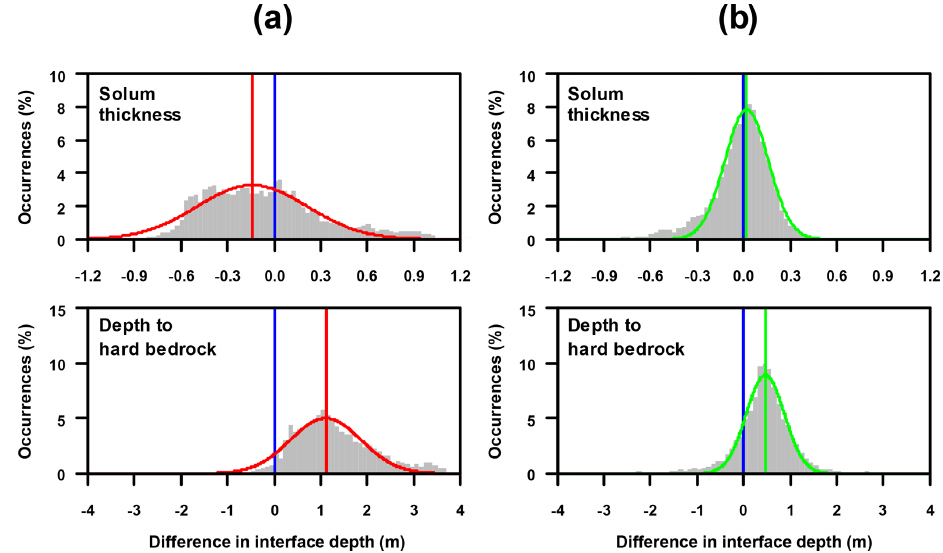
Figure 13. Distribution of differences between interface depths obtained using an ES of 2m without (a) or with the four interpolated levels of surficial apparent resistivity (b) and those obtained using an ES of 0.5m considering the overall 12 plot-scale ERT profiles measured in the Weierbach catchment. A normal distribution, whose centre is indicated by a vertical line, has been fitted for each histogram; the more the distribution is centred and narrowed on the zero value (vertical blue lines), the better the adequacy with interfaces derived from ERT images using an ES of